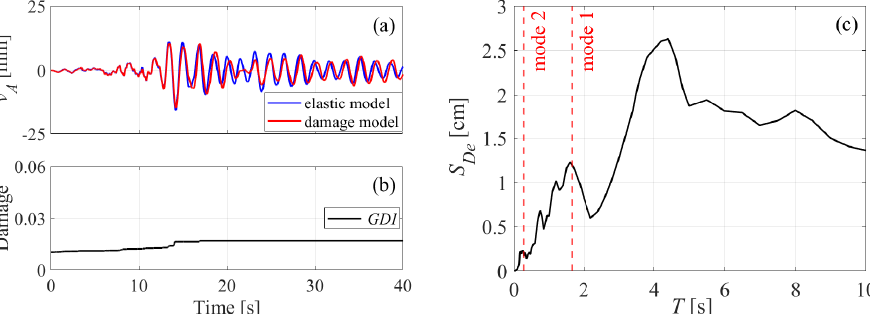
Figure 11. Earthquake SPM station: ( a ) elastic and damage responses of the equivalent pier, ( b ) evolution of the GDI , ( c ) elastic displacement spectrum.